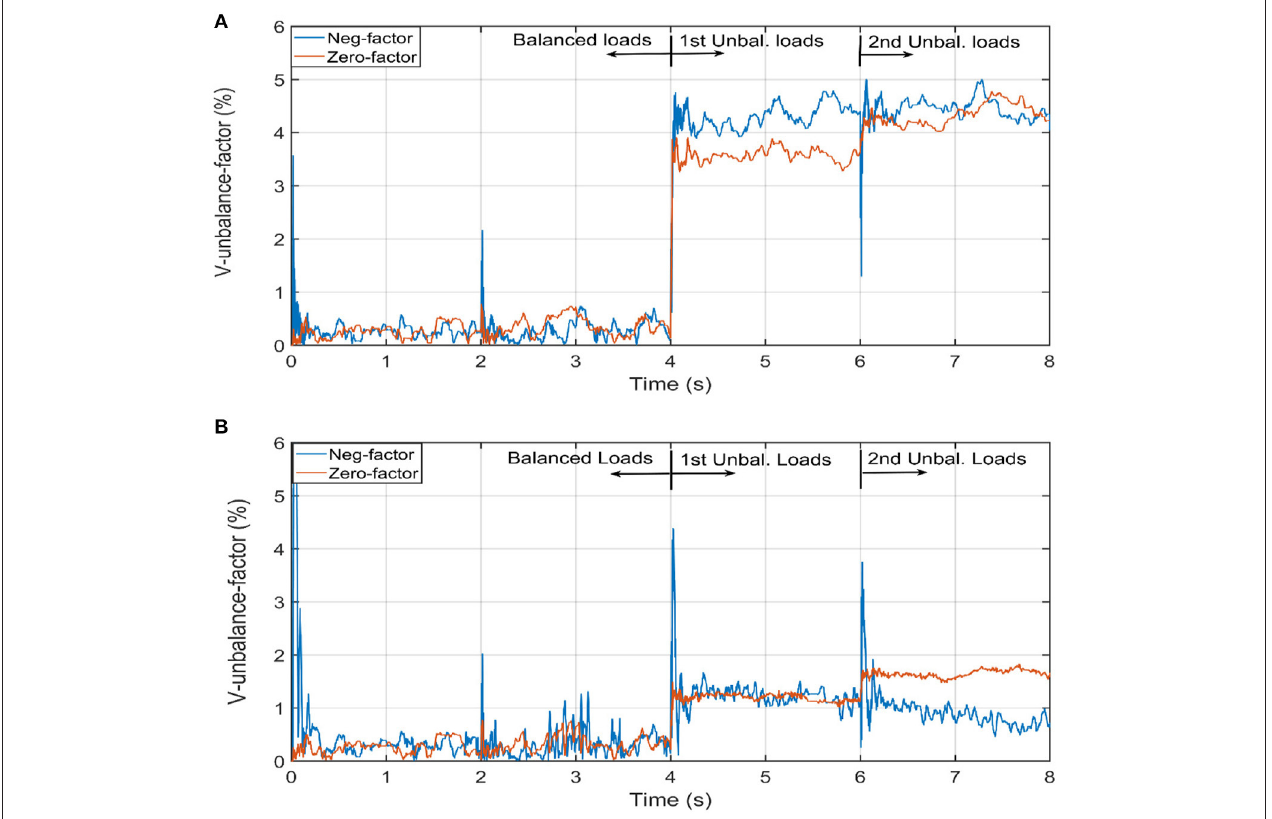
FIGURE 9 | Voltage unbalance factors before and after the activation of unbalance control. (A) Voltage unbalance factor without activation of unbalance control. (B) Voltage unbalance factor with activation of unbalance control.